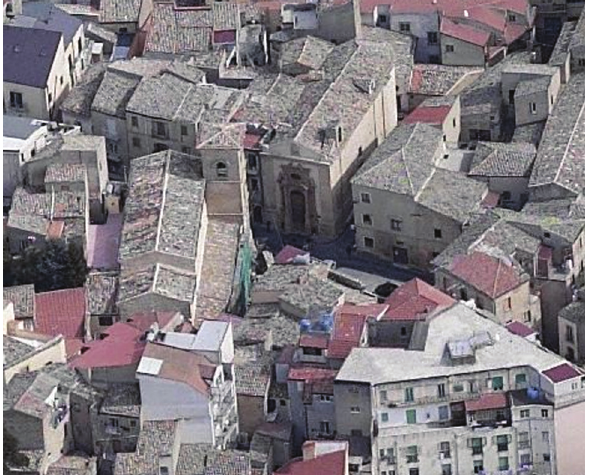
Figure 1. Piazza Paolo Francesco Neglia urban historical